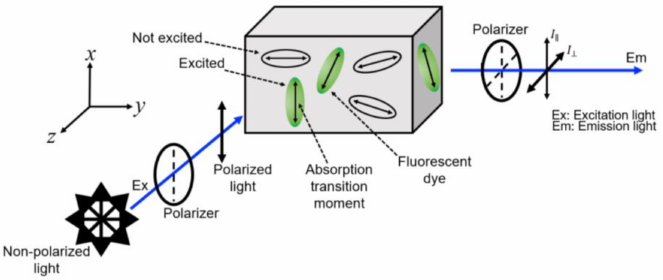
Figure 2. Schematic of fluorescence